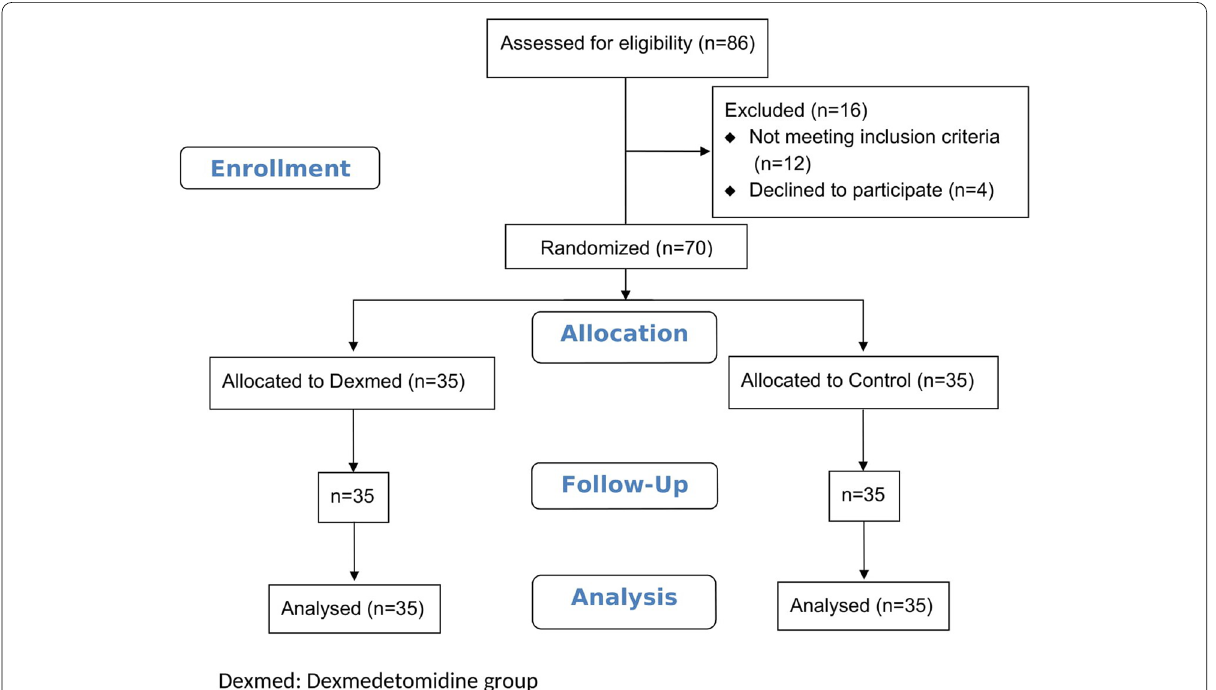
Table 2 Changes in heart rate in both studied groups